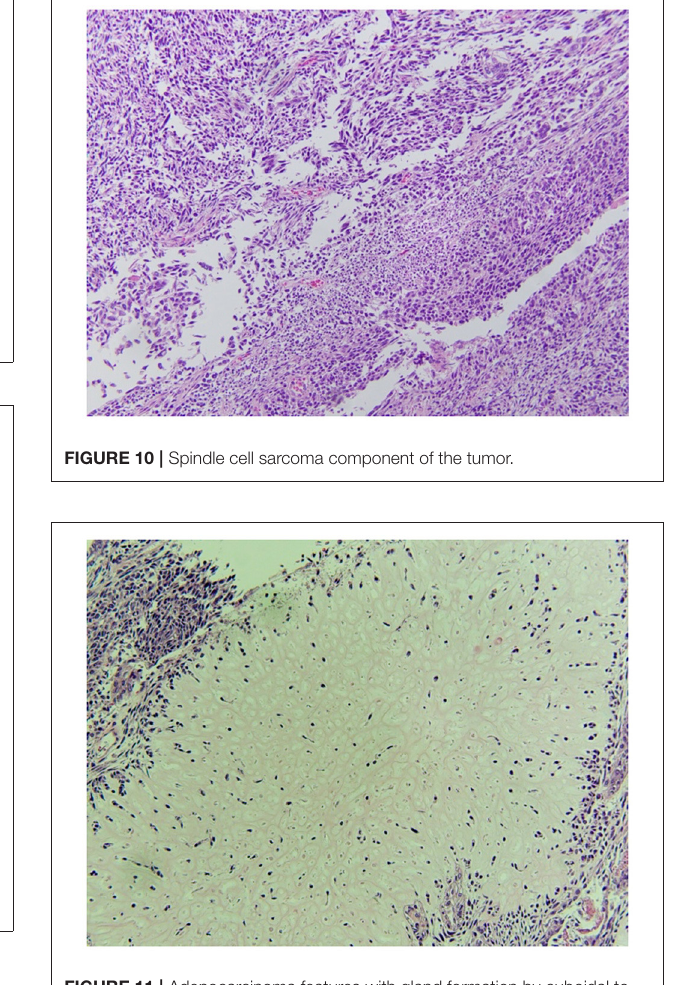
FIGURE 11 | Adenocarcinoma features with gland formation by cuboidal to columnar cells. Nuclei with intracytoplasmic mucin droplets and some very large, atypical nuclei are